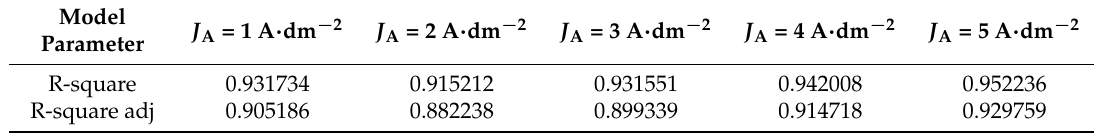
Table 4. Summary of the suitability of two of the selected statistical